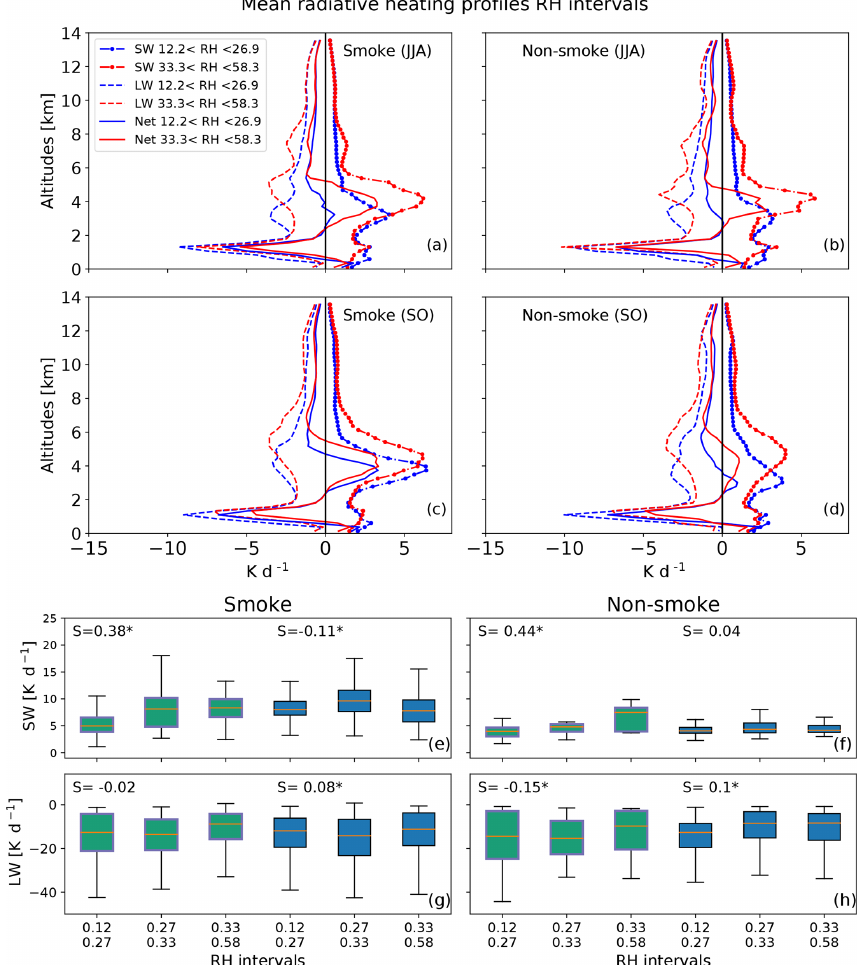
Figure 8. (a–d) Mean shortwave (SW), longwave (LW), and net (Net) radiative heating profiles for smoke and non-smoke cases with high and low RH (%) during June–July–August (JJA) and September–October (SO) of the period 2007–2010. (e–h) Box plots of SW heating in the aerosol layer (e, f) and LW cooling at cloud top (g, h) for three RH intervals (values given in fraction). (b, d, f, h) and (a, c, e, g) correspond to the smoke and non-smoke cases, respectively. Green boxes correspond to JJA and blue boxes to SO. For each case and period the Spearman correlation coefficient ( S ) between the full range of RH values and the SW (or LW) fluxes appears on top. Significant correlations (with p value < 0 . 05) are marked with a star ( ∗ ). RH values are derived from variables in the CloudSat ECMWF-AUX